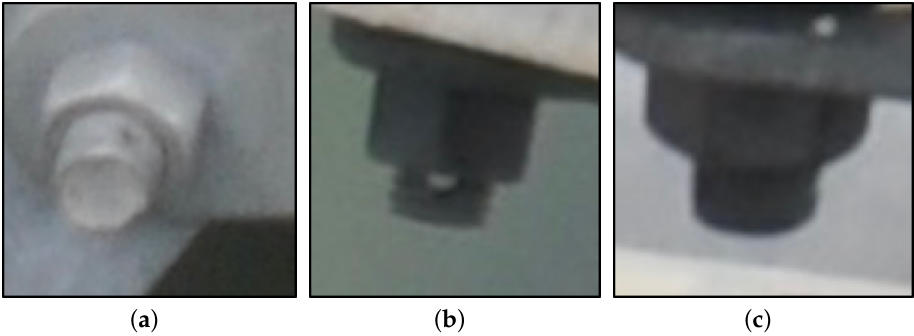
Figure 7. Multiangle image of bolt structure with missing pin. ( a ) Bottle view. ( b ) Front view of visible pin. ( c ) Front view of invisible pin.